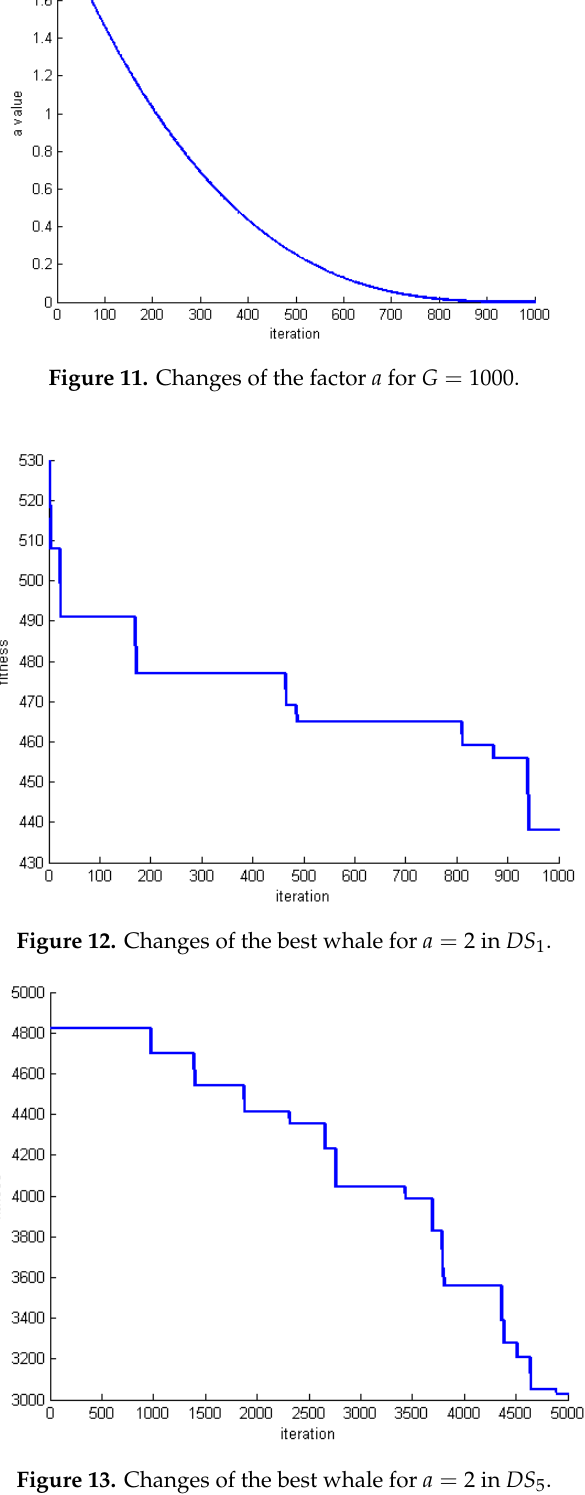
Figure 11. Changes of the factor a for 1000 = G .